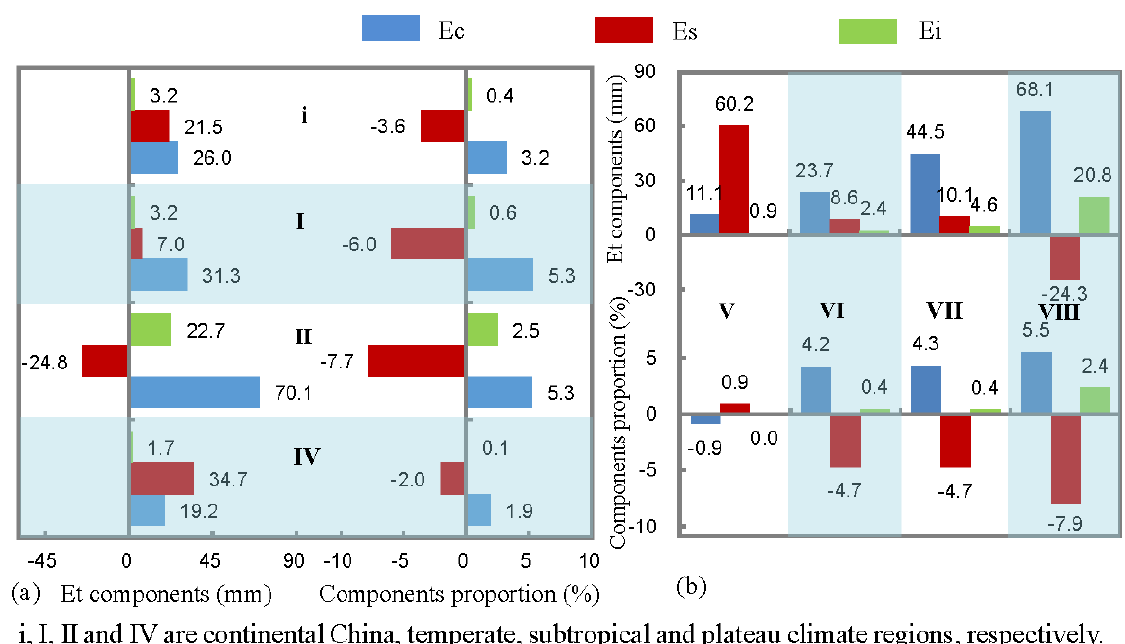
Figure 7. The changes of ET components for forestry ecosystems.